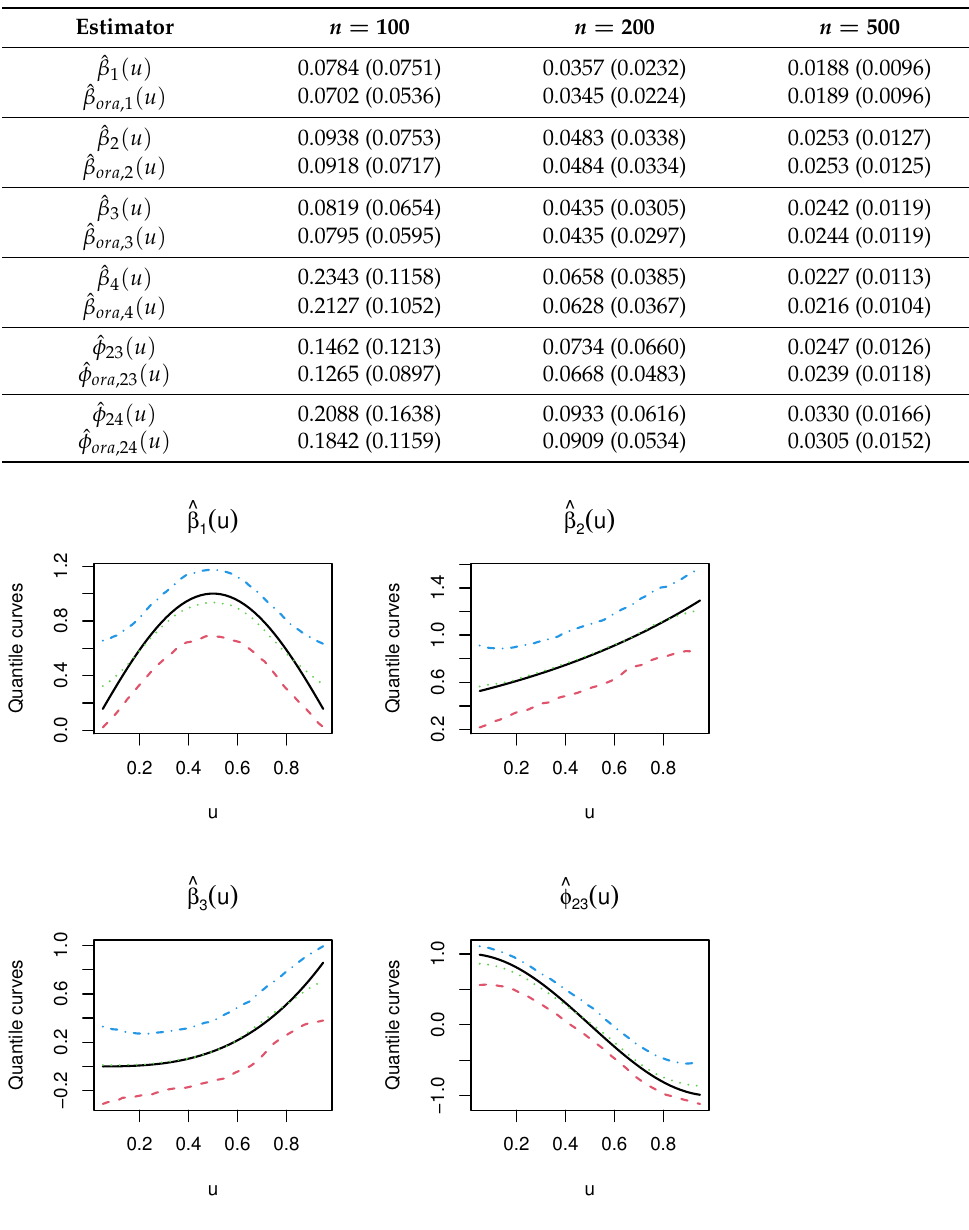
Figure 1. Estimated quantile curves of Model 1. Dash-dot lines are 0.95 quantile curves, dotted lines are 0.50 quantile curves, dashed lines are 0.05 quantile curves, and solid lines are the real function curves. The dash-dot and dashed lines indicate 90% confident